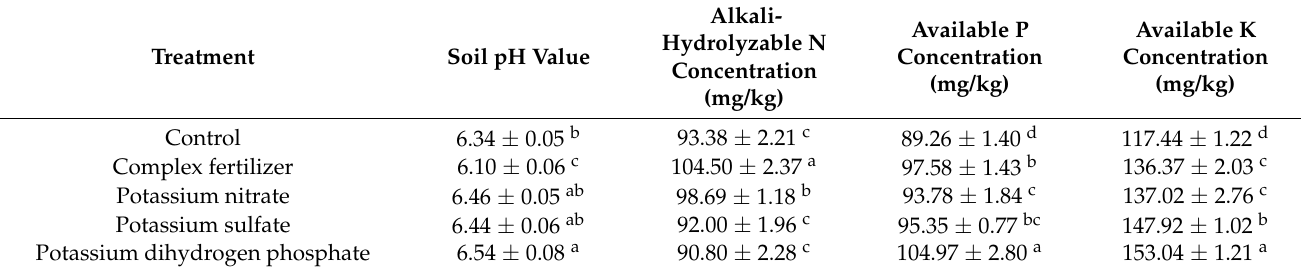
Table 2. Soil pH value and available nutrient